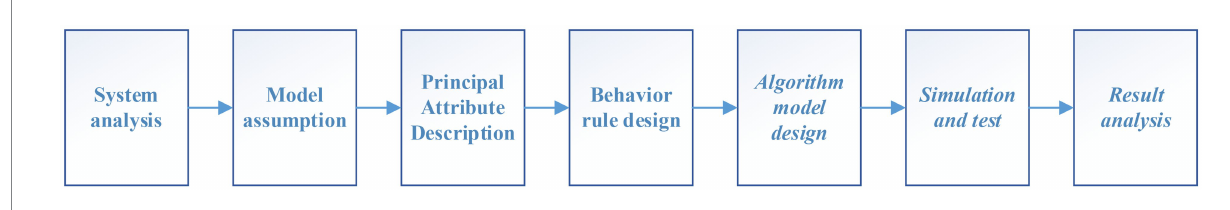
FIGURE 1 The framework for the construction of the economic dispatch